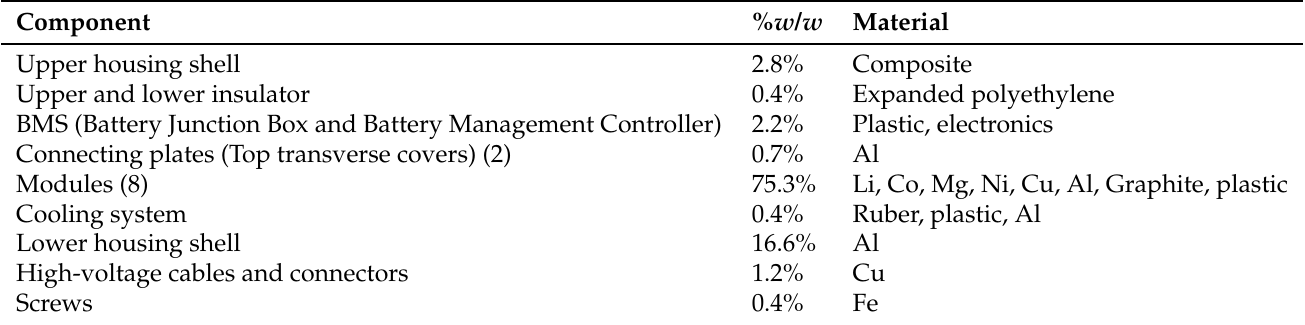
Table 1. Audi A3 Sportback e-tron battery pack constructive components and